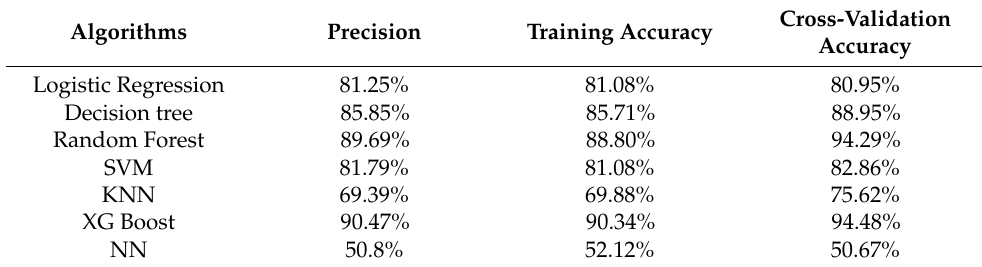
Table 4. Classifier’s performance comparison for 3*3 Arrangement